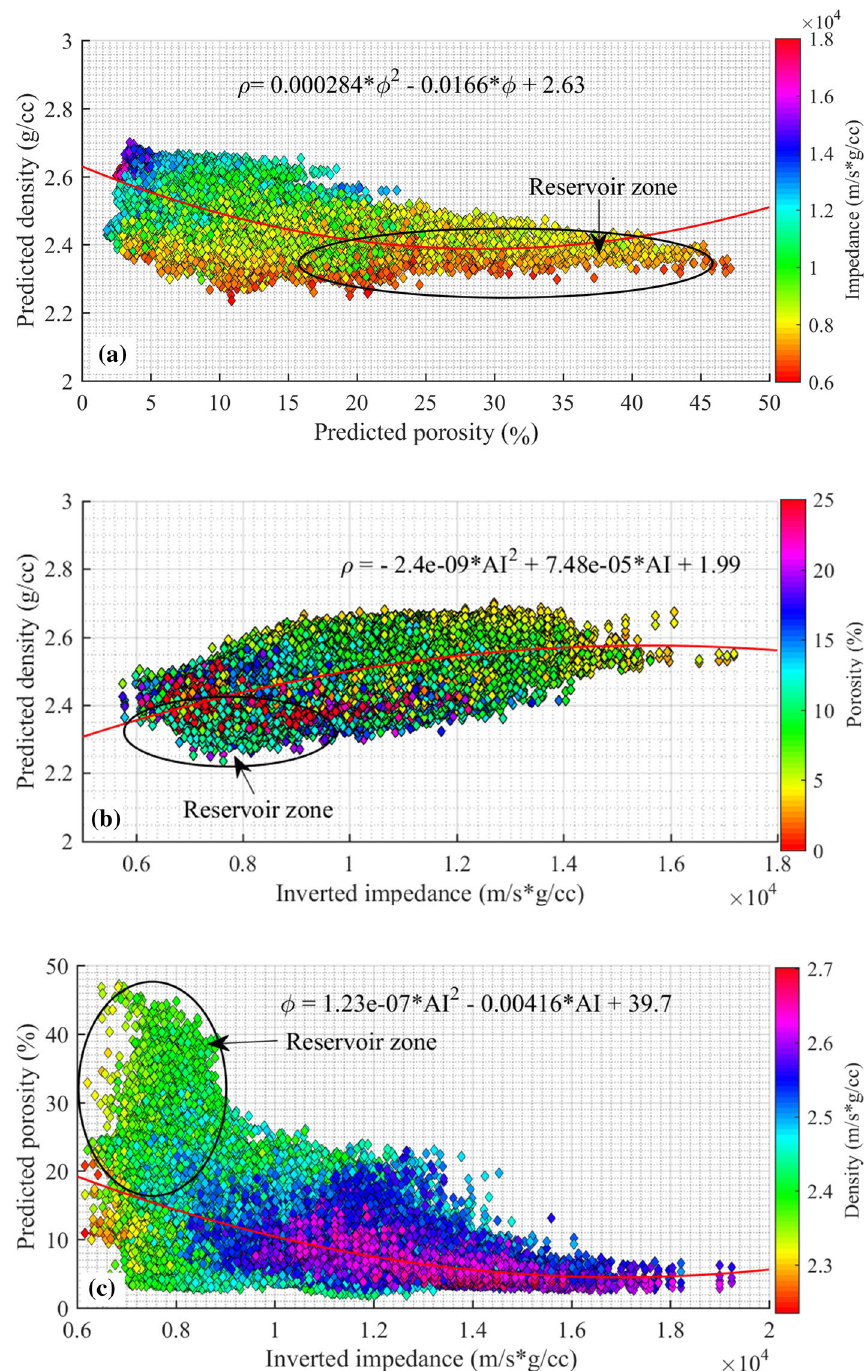
Fig. 13 Cross-plot of a pre- dicted porosity versus predicted density, b predicted density versus inverted impedance, and c predicted porosity versus inverted impedance seismic section centered 1065 ms with 100 ms width. The reservoir zone is highlighted by the ellipse. The relationships between inverted properties are shown on top of the respective